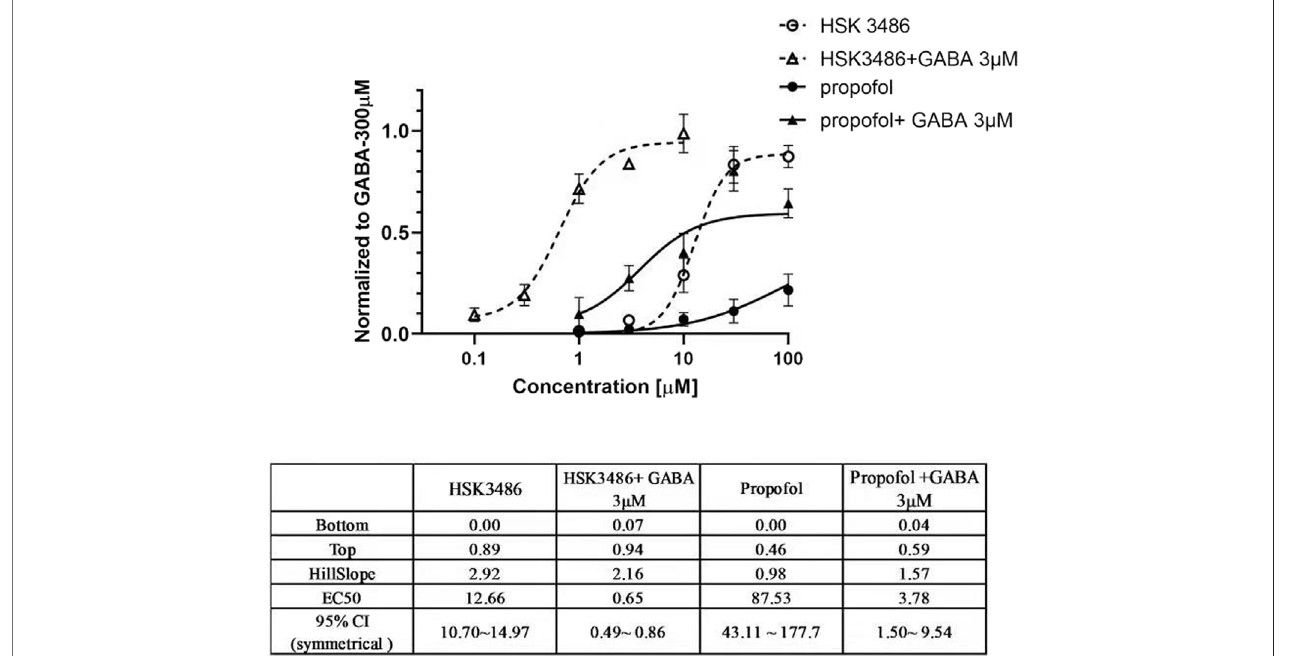
FIGURE1| PotentiatoranddirectagonisteffectsofHSK3486ongamma-aminobutyricacidtypeA(GABA A )receptors.Datashowthemeancurrentincrease±SD evokedby3 μ MGABAinthepresenceorabsenceofHSK3486orpropofol,orevokedbyeachoftherespectivedrugsonitsown.Thecurrentincreaseisshownasafold difference from the current observed with 300 μ M